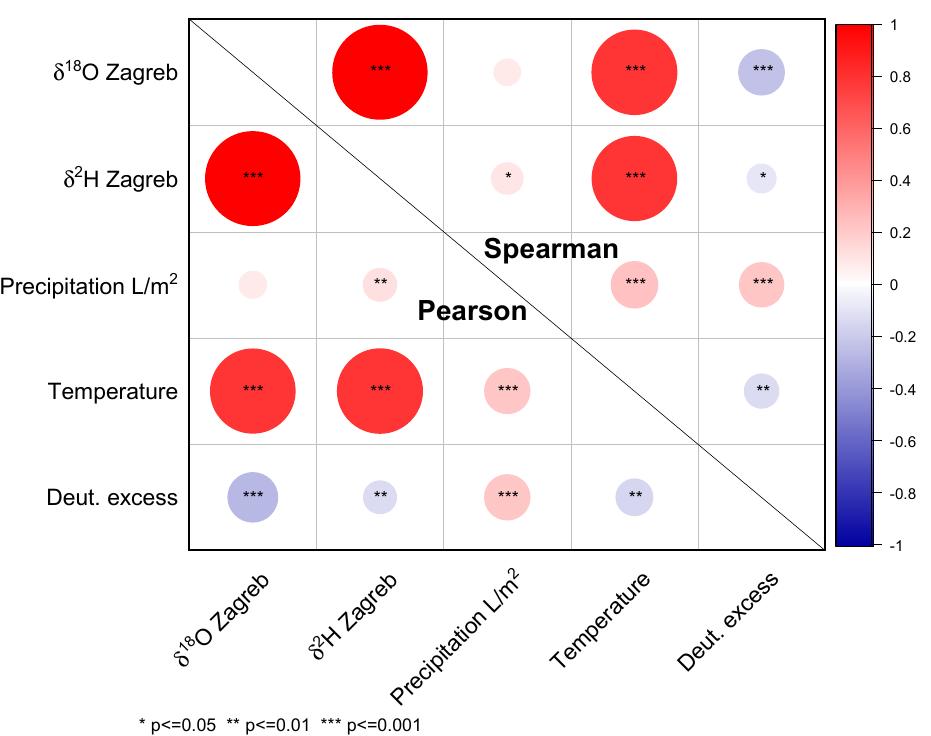
Figure 4. Pearson’s r and Spearman’s ρ correlation. The correlation strength is shown both in the color and size of the circles. Asterix denotes the statistical significance of the correlation.